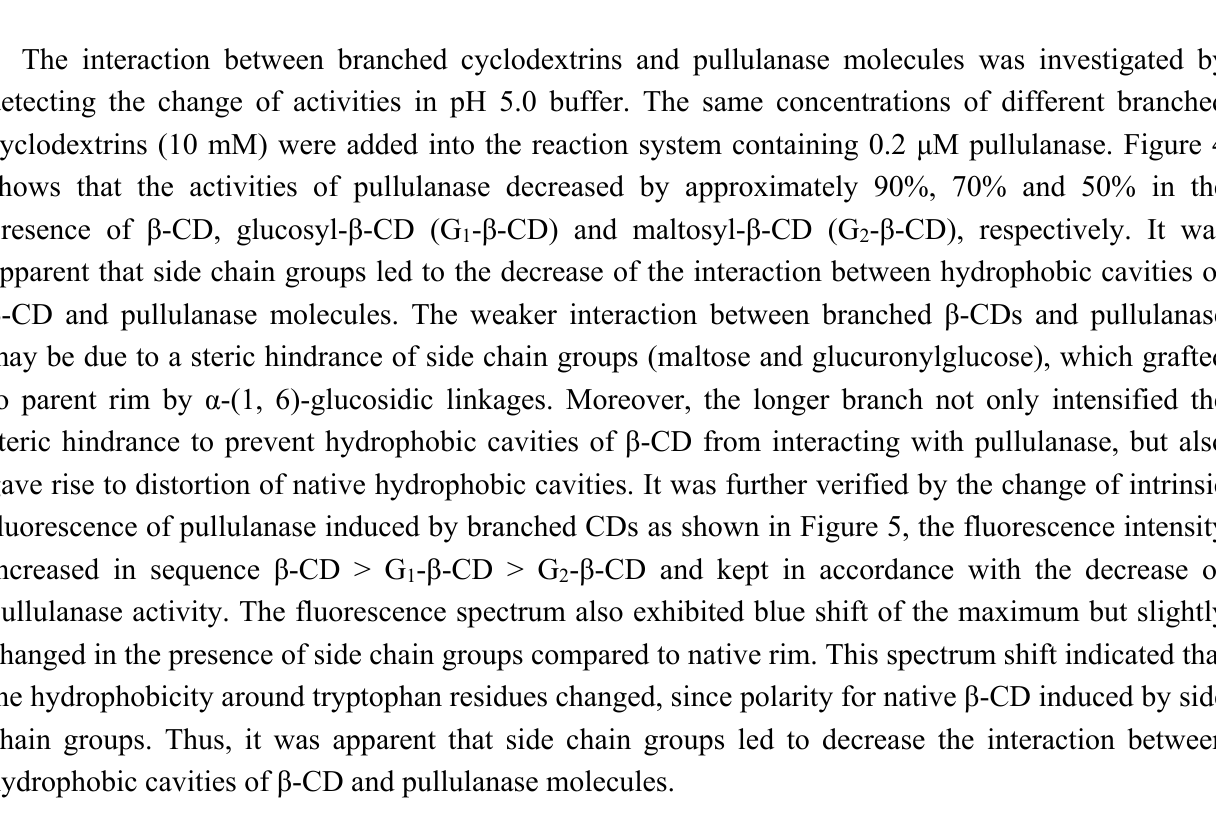
Figure 4. Effects of side chain groups of β -CD on pullulanase